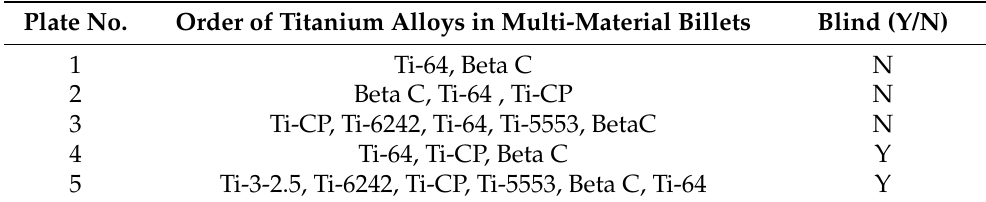
Table 2. Compositions of the multi-material billets and whether or not the composition of the machined billet was unknown to those analysing the force fingerprint (blind